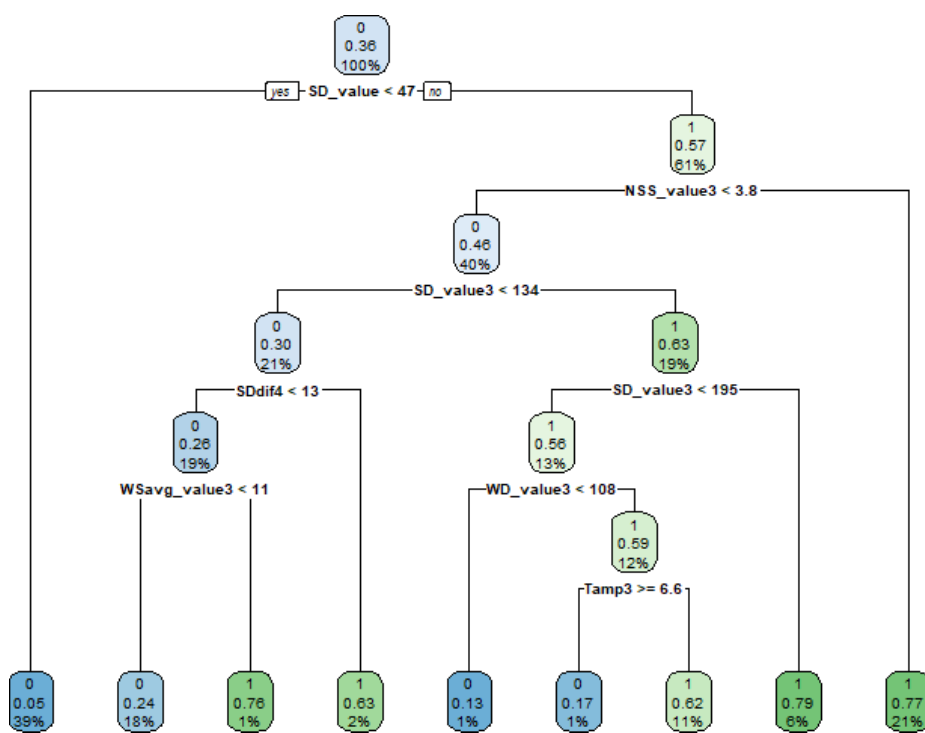
Figure 9. The decision tree of weather variables triggering slab avalanches. Numbers 1 and 0 denote avalanche day and non-avalanche day. The single value means the probability of occurrence/non-occurrence of avalanche release. The percentage signifies what percent of data are influenced by the split node from the wet SMOTE avalanche dataset.